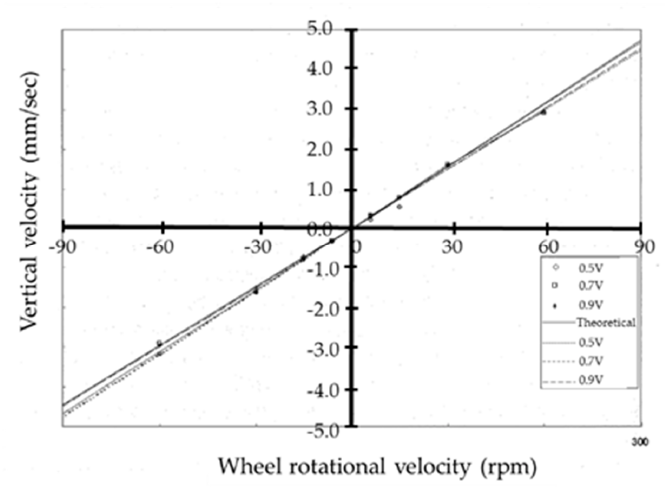
Figure 21. The relationship between the wheel rotational velocity and climbing velocity in the vertical direction obtained from the measurement results. Descending movement is indicated by negative wheel rotational velocity values, the straight line is the theoretical value of the wheel rotational velocity, and the dashed lines are the result of approximating the measurement results, using the least squares method, to straight lines passing through the